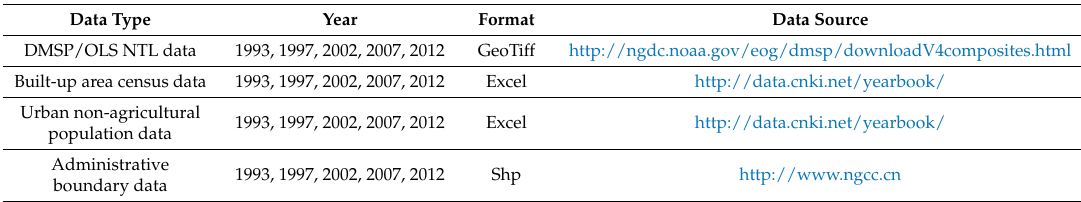
Table 1. The datasets used in our study.